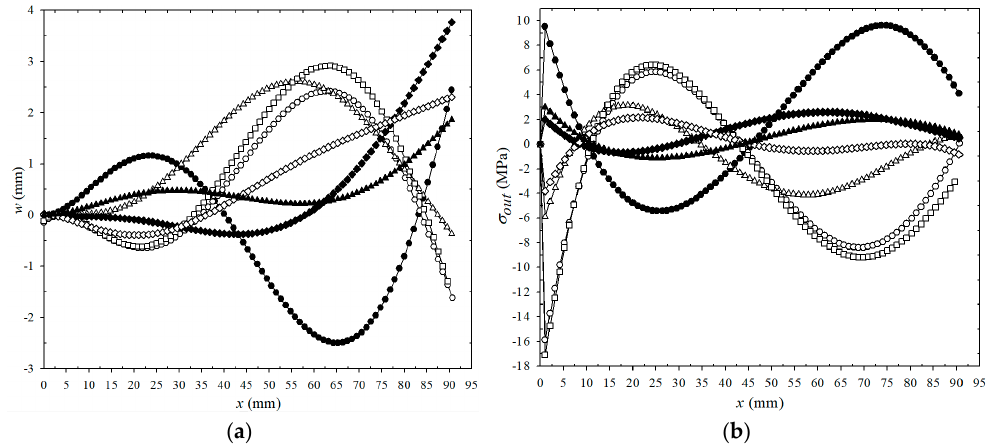
( a ) ( b ) Figure 19. L = 100 mm, D = 8 mm t p = 600 µm plate, u f = 40 m/s, RE = 21621: ( a ) characteristic shapes ; Figure 19. L = 100 mm, D = 8 mm t p = 600 µ m plate, u f = 40 m / s, RE = 21621: ( a ) characteristic shapes; ( b ) stress distribution on the outer fiber for the above shapes. ( b ) stress distribution on the outer fiber for the above shapes. Energies 2020 , 13 , x FOR PEER REVIEW 26 of 29